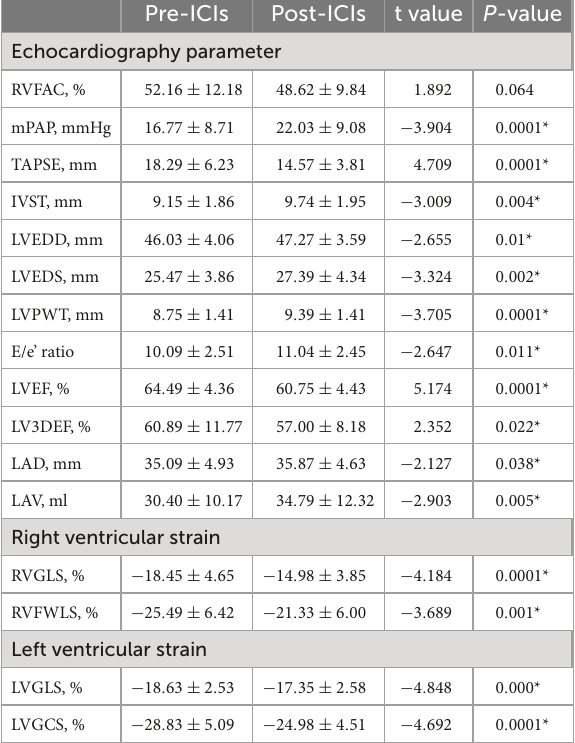
TABLE 3 Patients’ echocardiography data before and after immune checkpoint inhibitors (ICIs)